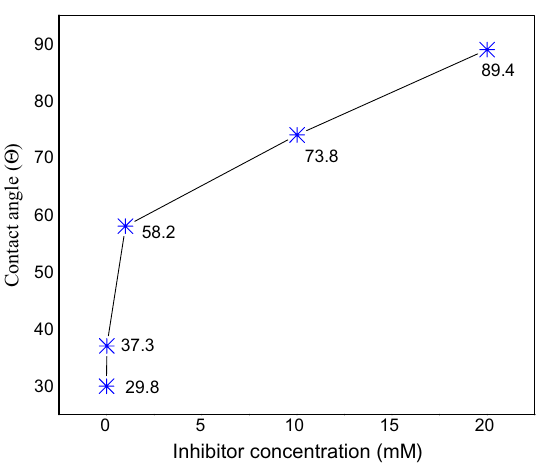
Figure 8. Illustrates the surface contact angles of the steel surface uninhibited with various concentrations of expired Ampicillin drug at 25